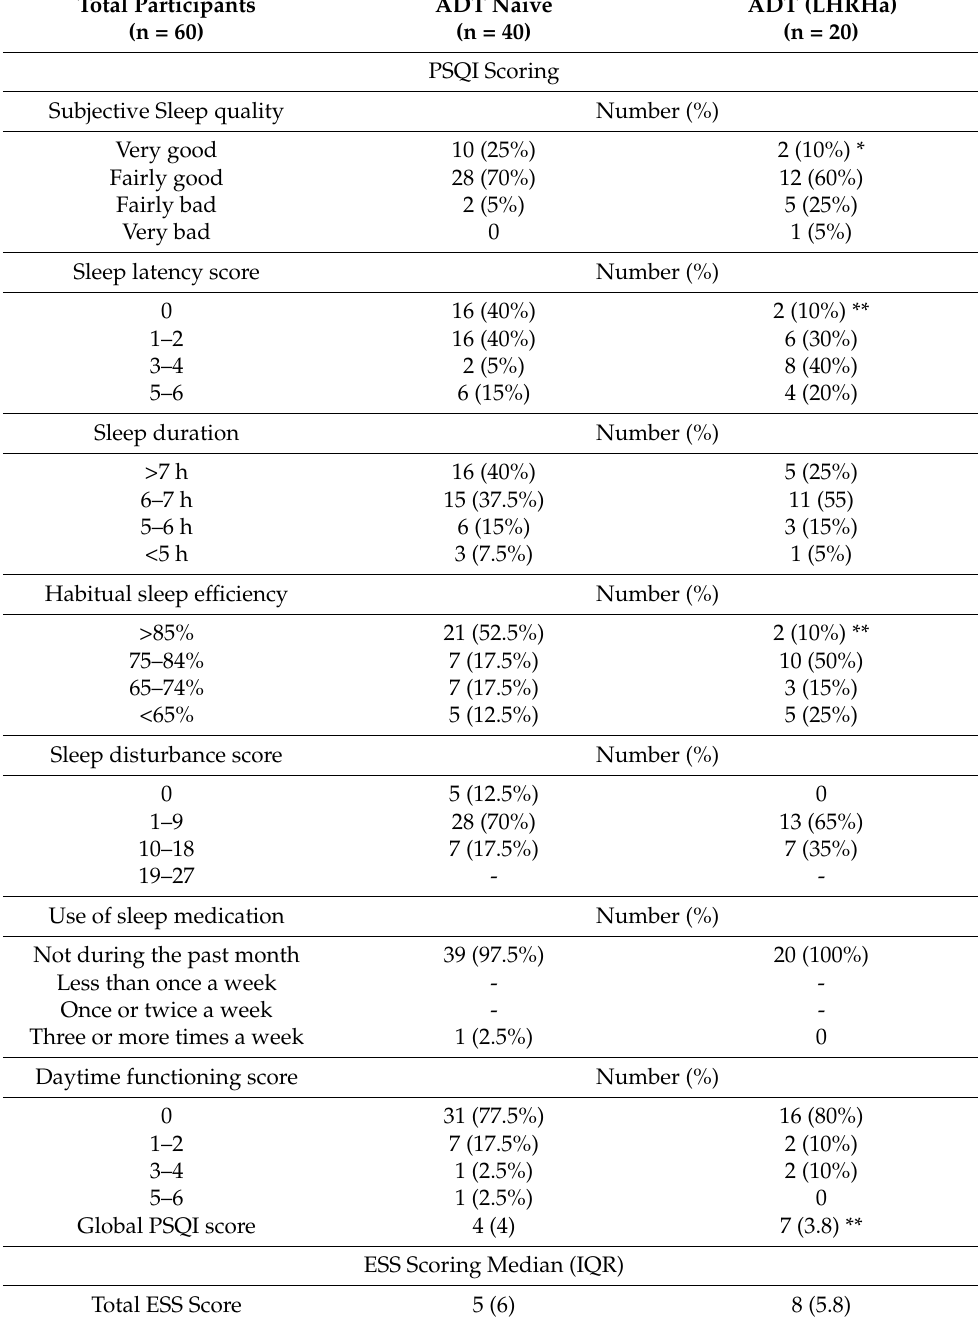
Table 3. Subjective and objective sleep characteristics of participants who were LHRH naïve or had been on LHRH treatment. PSQI data are presented as number of participants and percentage. ESS data are presented as either mean ± standard deviation or median (interquartile range), depending on data